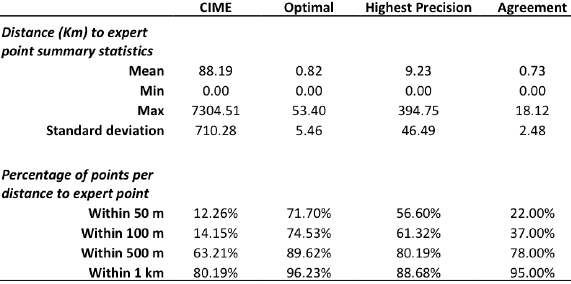
Figure 17. Comparison of CIME and hybrid approaches with the expert